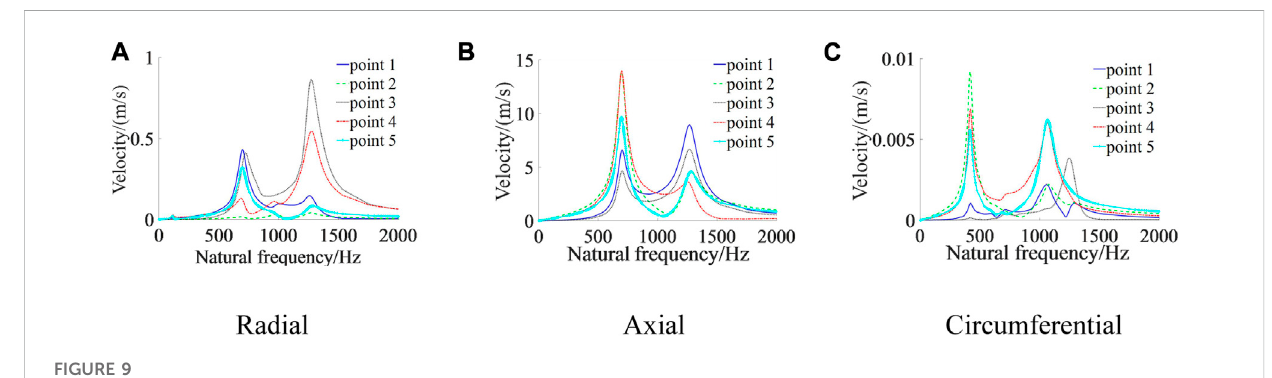
FIGURE 9 Velocity – frequency curve of the measurement point (A – C)